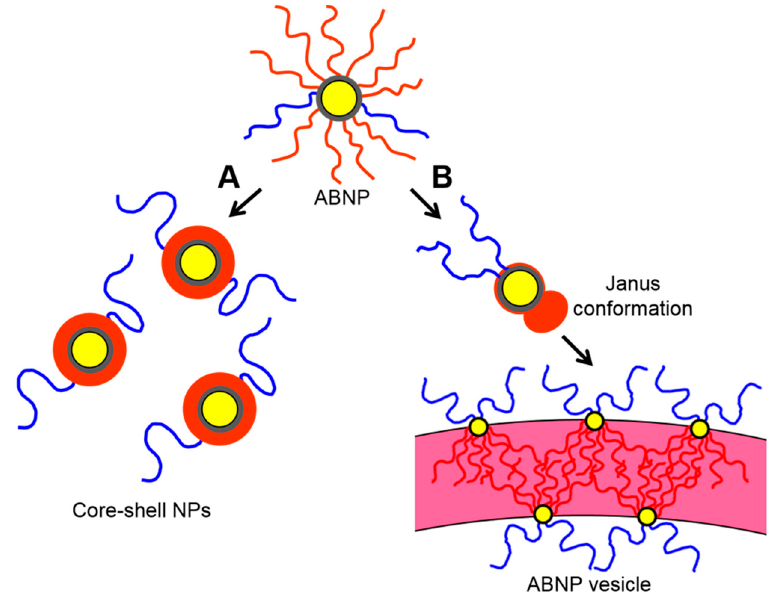
Figure 7. Schematic showing two conformational rearrangement pathways for PS/PMAA-CdS mixed brushes above the critical water content. ( A ) Centrosymmetric condensation of PS with no salt addition and ( B ) non-centrosymmetric condensation of PS with salt addition and subsequent self-assembly of Janus particles into QD-polymer vesicles.